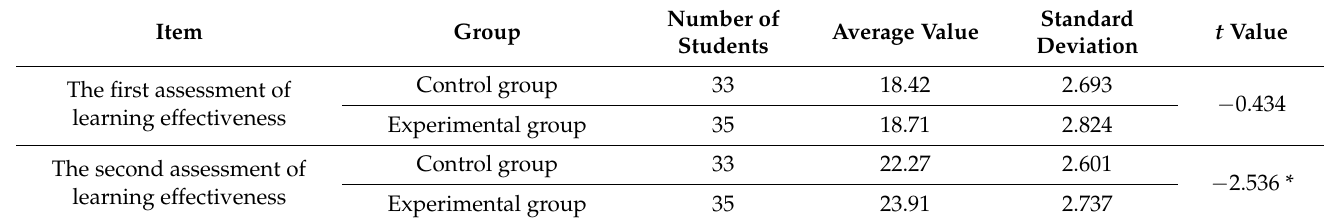
Table 8. Recapitulation sheet of basic electricity practical learning effectiveness scores in terms of attitude.